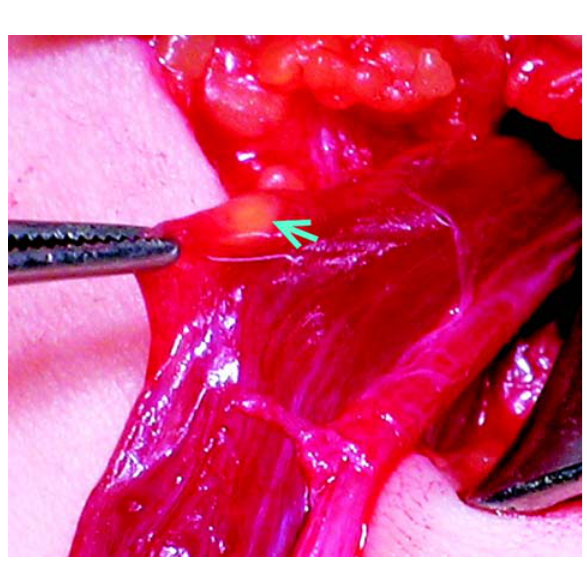
Figure 1 – Intraoperative photograph during orchidopexy for criptorchidism. Arrow and forceps tip marks the well-defined yellow nodule.